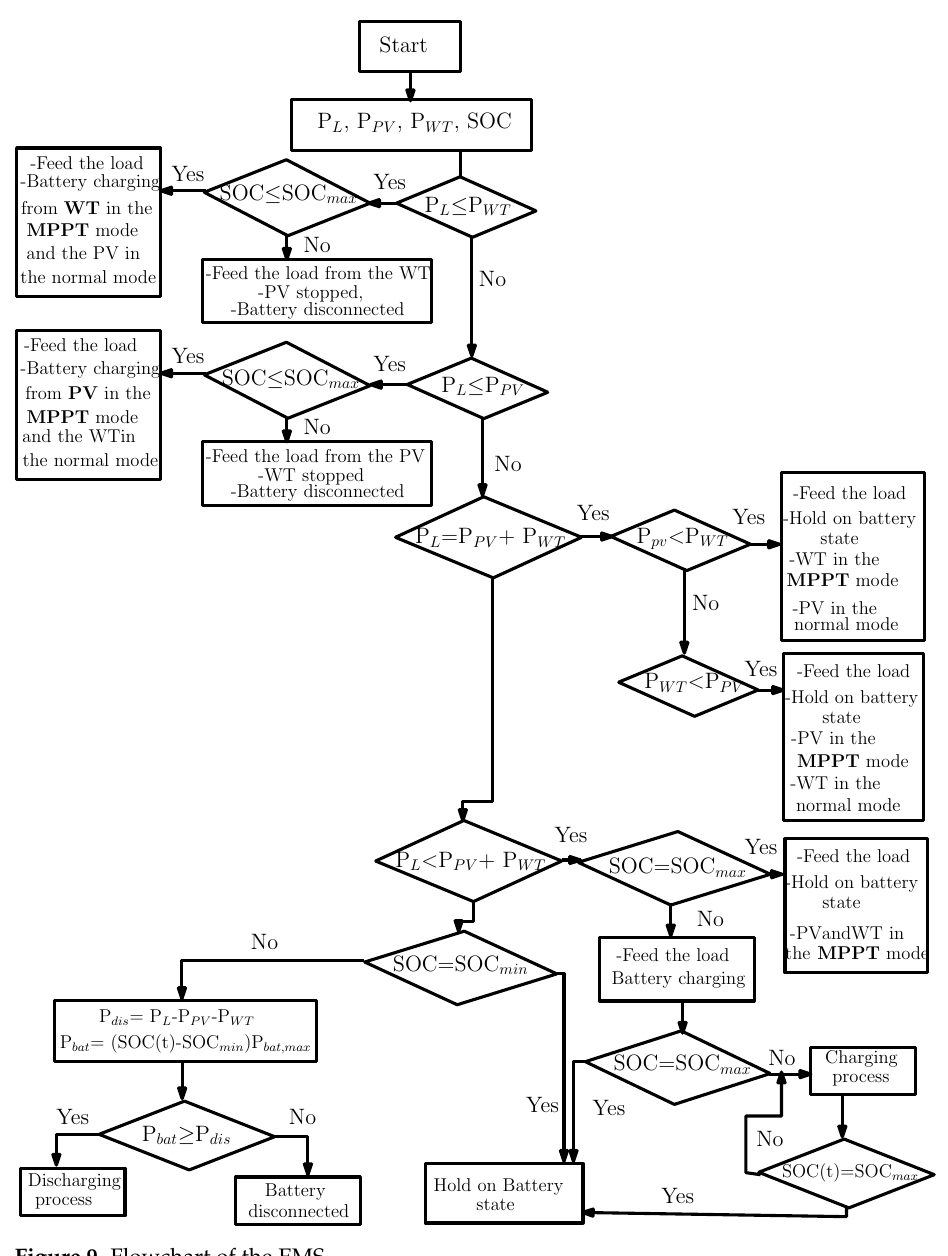
Figure 9. Flowchart of the